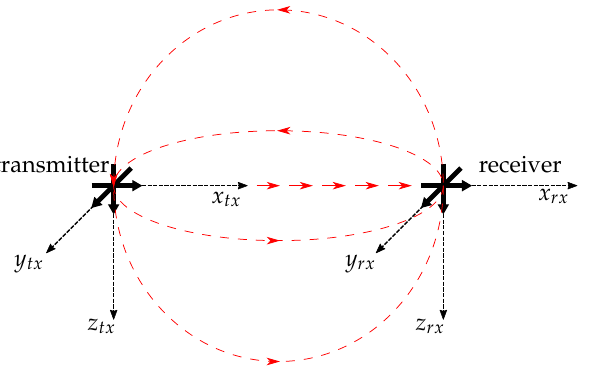
Figure 6. Aligned transmitter and receiver [15].